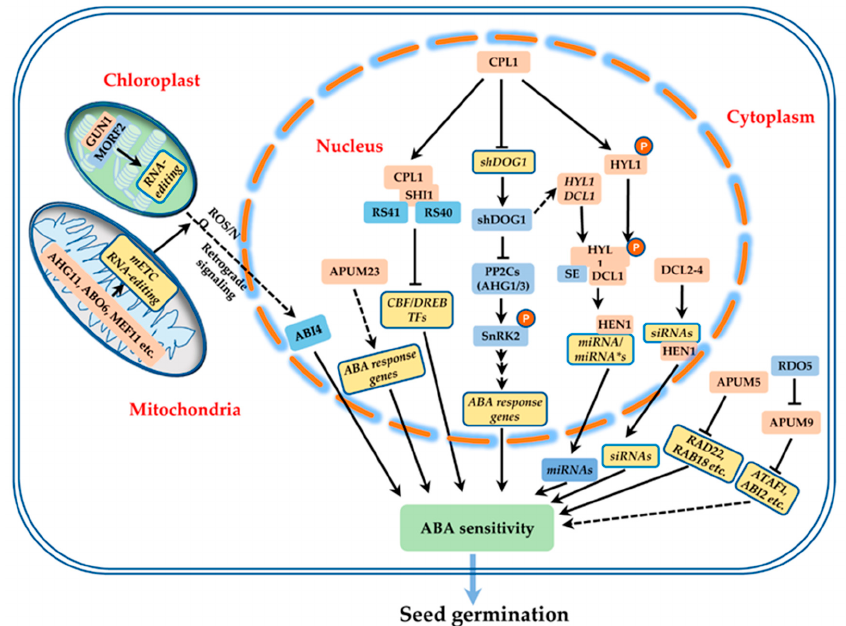
Figure 2. The model of various RBPs involved in ABA-related signaling pathway in the Arabidopsis seed germination and/or dormancy. All PRBs are showed in pink box, the targets of RBP are in yellow box, and the blue boxes are the other components in the signaling transduction. All proteins are normal font, and mRNAs are showed with italic font. Arrows with lines or dashed lines indicate the proteins and/or genes are directly or indirectly regulated by upstream factors, respectively. Lines with bars indicate the negative regulation in the signaling. P, phosphate; PP2C, protein phosphatase 2C; SnRK2, SNF1-related protein kinases 2; RD22, responsive to dehydration 22; RAB18, ABA-responsive gene 18; ATAF1, Arabidopsis transcription activation factor 1; ABI2, the phosphatase ABA Insensitive 2; ABI4, ABA-INSENTIVE 4 (a nuclear transcriptional factor); CBF/DREB, C-repeat binding factor / dehydration-responsive